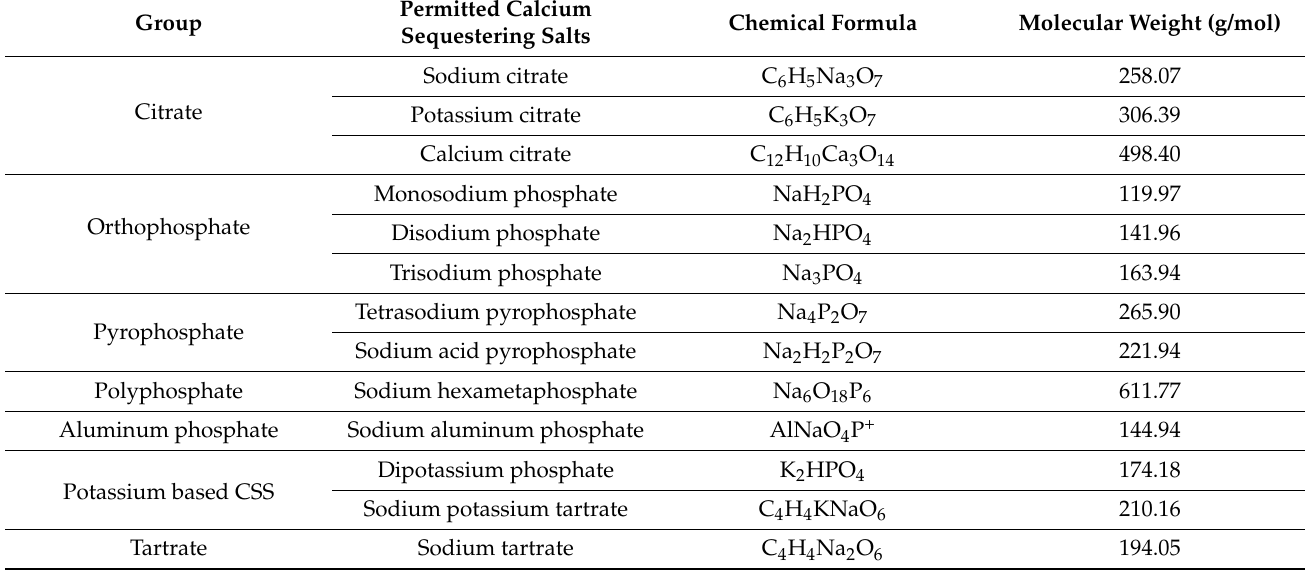
Table 1. Permitted calcium sequestering salts in processed cheese as per code of federal regulations 21CFR133.169